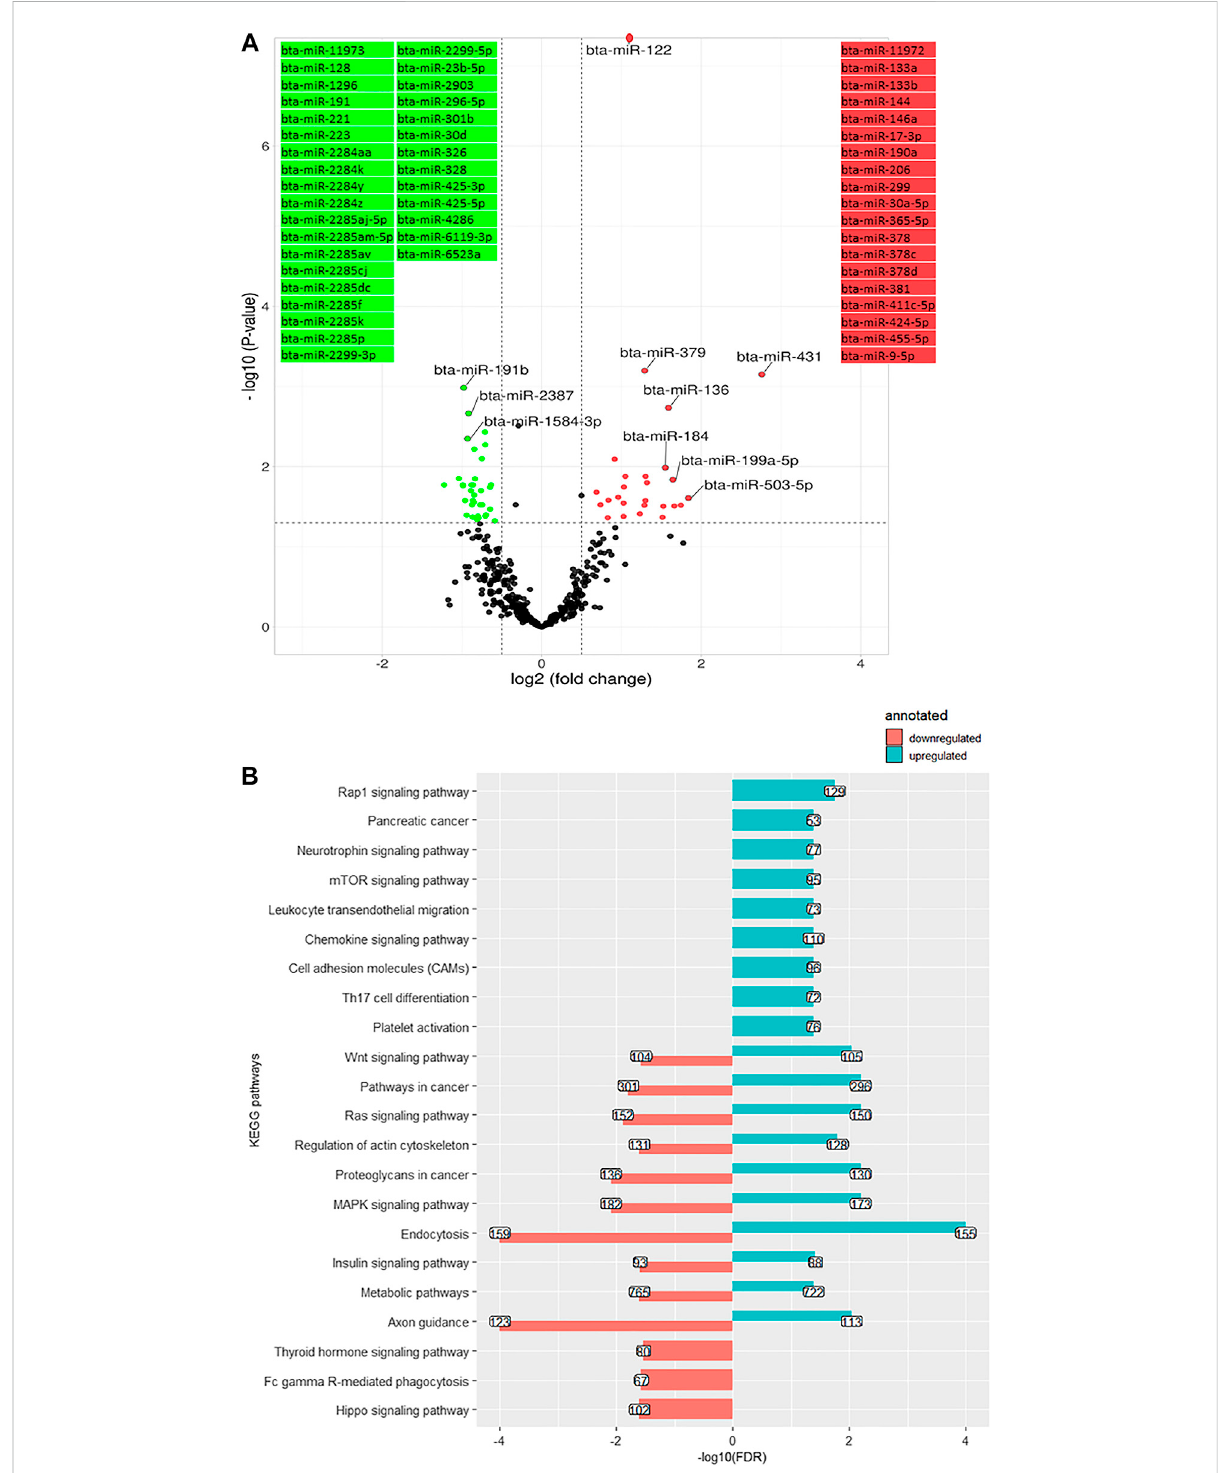
FIGURE 6 (A) .Volcanoplot representing differentiallyexpressedmiRNA (DEM) between day+28and +63 relativeto parturition;increased(red dotsintop right) and decreased (green dots in top left) miRNA in d+63/d+28 are highlighted ( p < 0.05 and log2 fold change (FC) > 1.3). (B) . KEGG pathways annotated to DEM; Bars indicate proportional to the false discovery rate (FDR) adjusted p -value, and the box on each bar represents the genes count